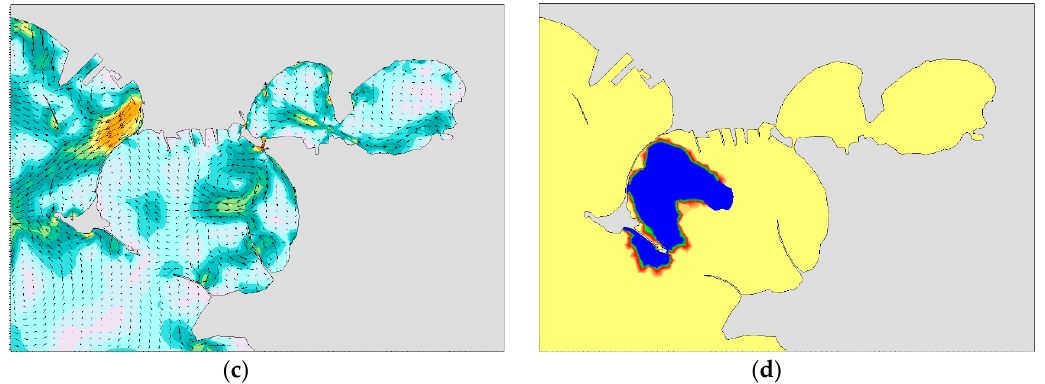
Figure 12. Cont. Figure 12. Cont.